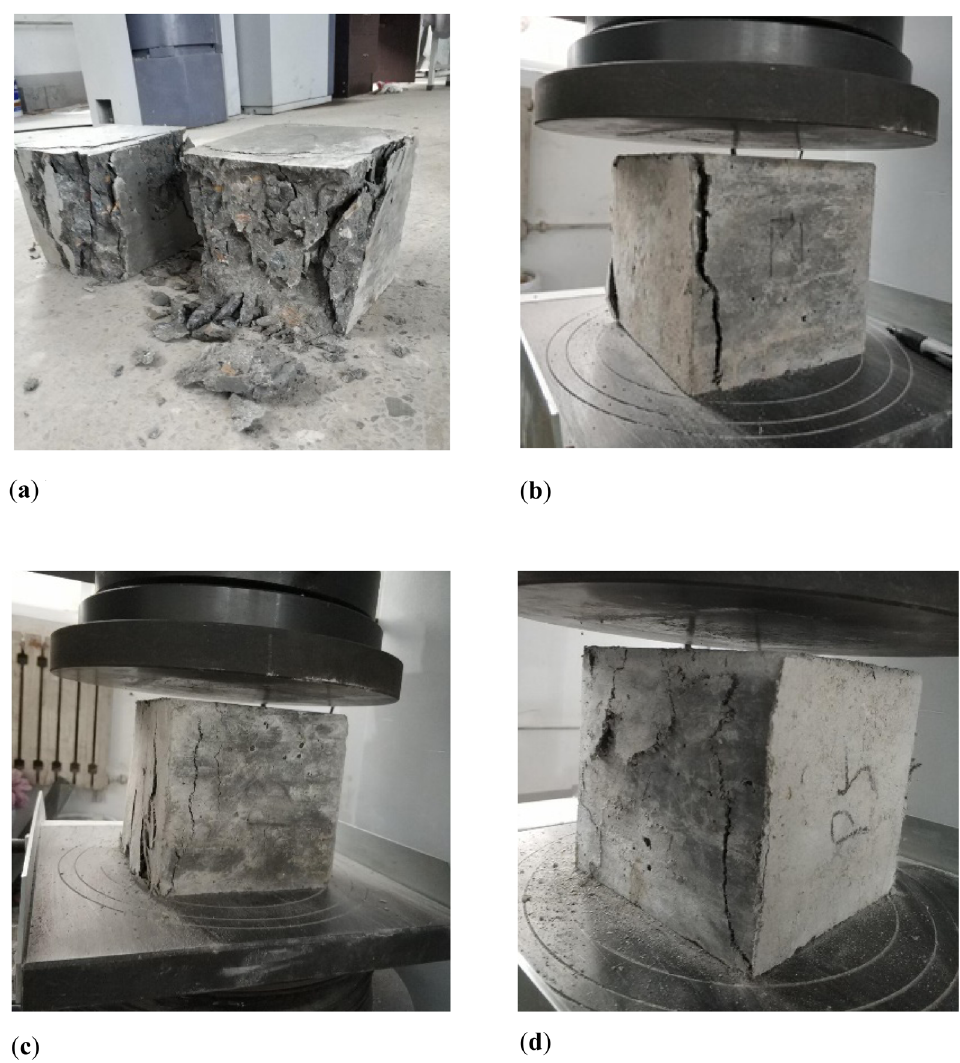
Figure 8: Cubic compression failure patterns of specimens. ( a ) Without PVA fi ber, ( b ) 0.2% PVA fi ber, ( c ) 0.4% PVA fi ber, and ( d ) 1.0% PVA fi